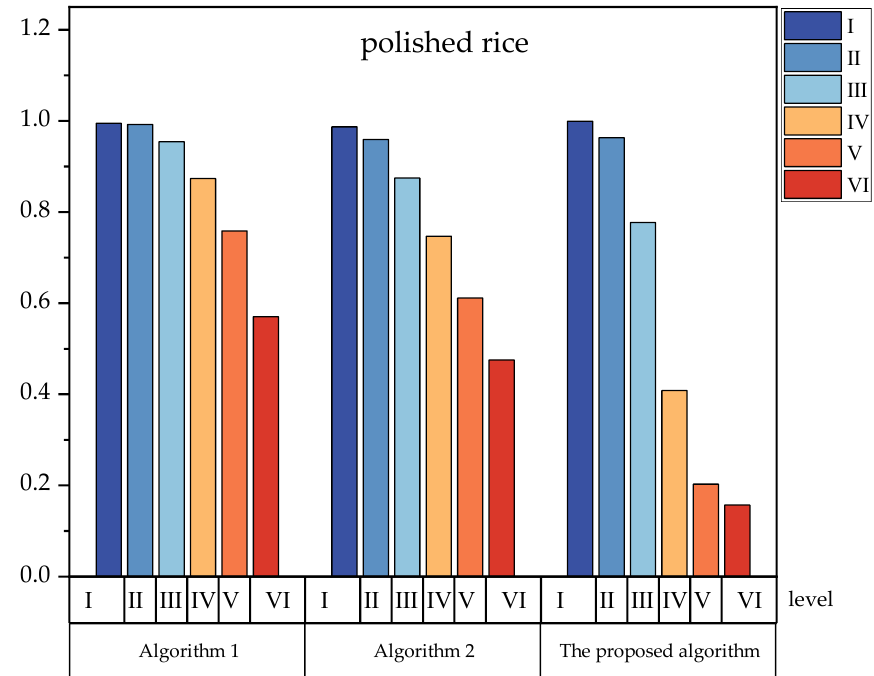
Figure 6. Histograms of the membership degrees of polished rice.